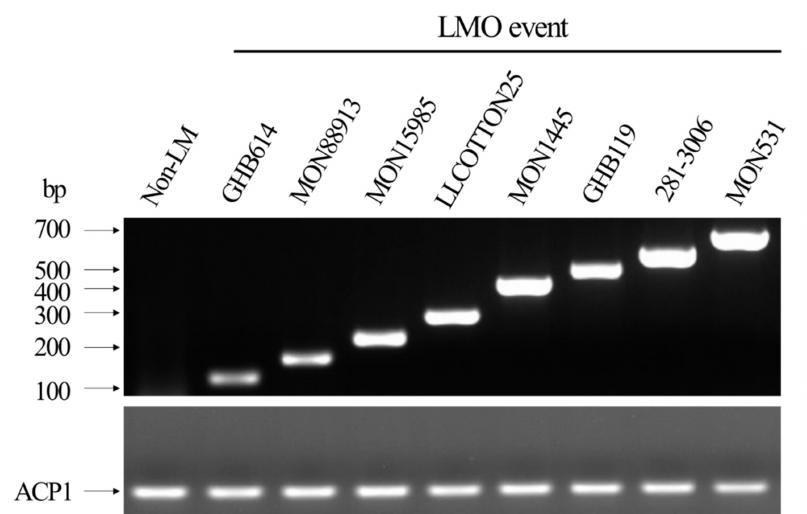
Figure 3. Gel loading analysis of PCR products of eight LM events. PCR products of Non-LM, GHB119, MON88913m MON15985, LLCOTTON25, MON1445, GHB119, 281-3006, and MON531 were electrophoresed on a 2.5% agarose gel (Lane M: 100 bp DNA Ladder; Lane 1: Non-LM; Lane